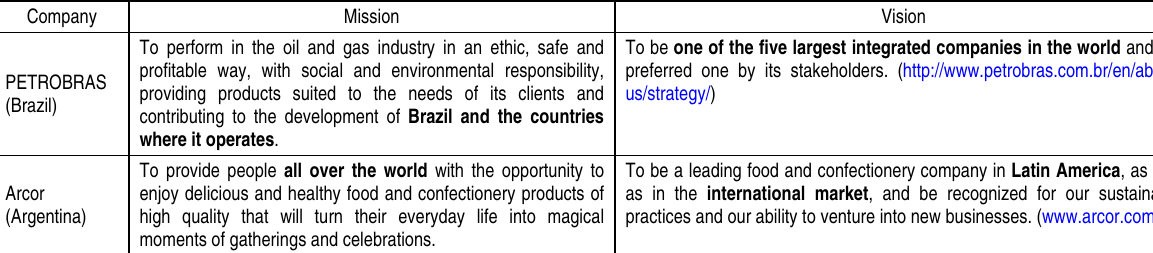
Table 3. Examples of the presence of IS in the mission and vision of the